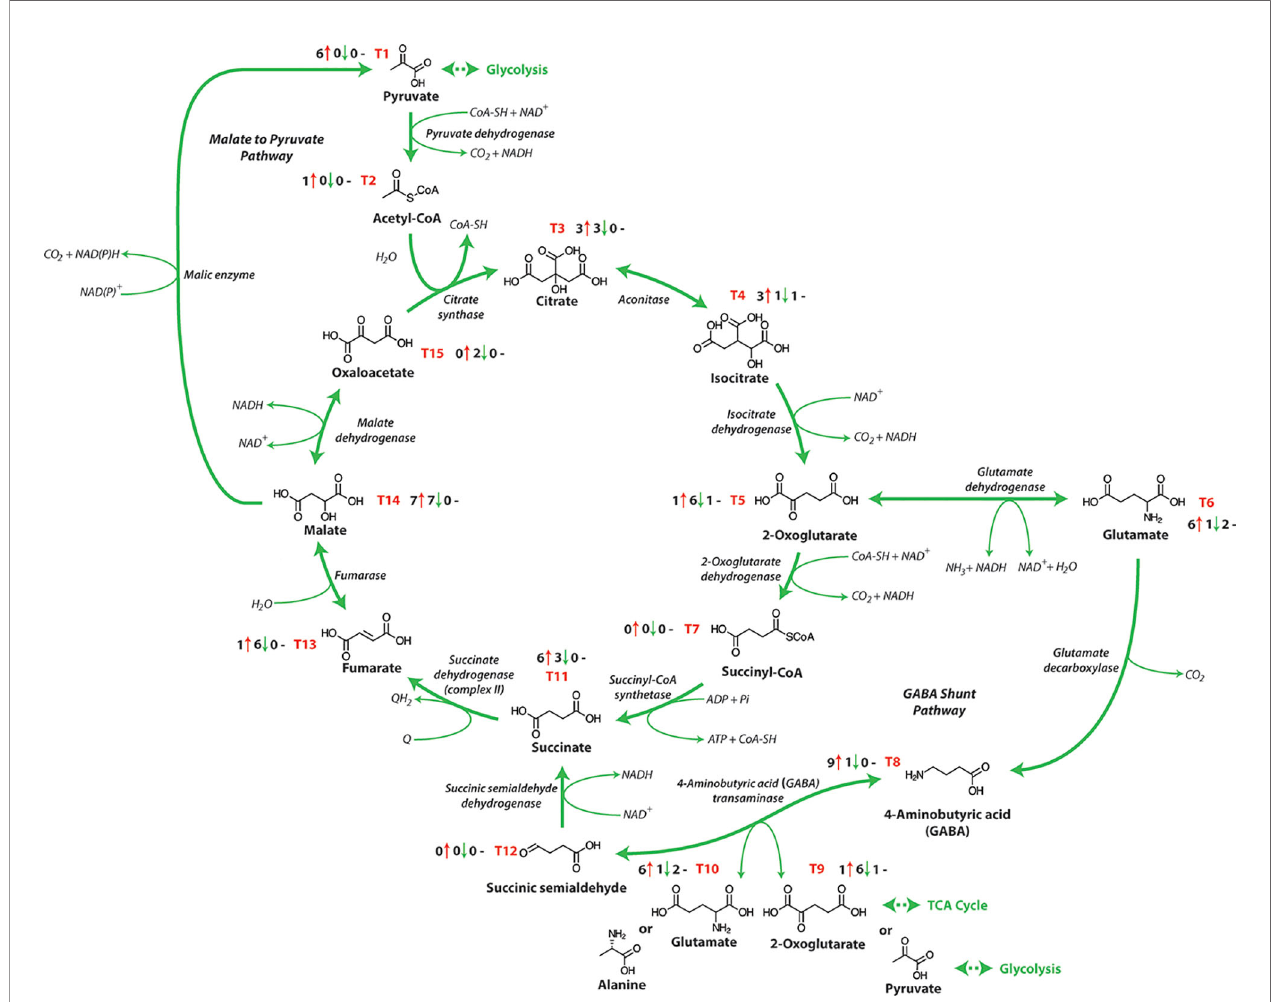
FIGURE 3 | The tricarboxylic acid cycle. NAD + , nicotinamide adenine dinucleotide (oxidized); NADH, nicotinamide adenine dinucleotide (reduced); ATP, adenosine triphosphate; ADP, adenosine diphosphate; Pi, inorganic phosphate; GTP, guanosine triphosphate; GDP, guanosine diphosphate; Q, qunione; QH 2, dihydroquinone. T1-T15 represent each metabolite of the TCA pathway and the number before the red arrows indicate the number of papers that report an increase in abundance, the number before the green arrows indicates the number of papers that report a decrease in abundance, and the number before the black dashes indicates the number of papers that report no change in